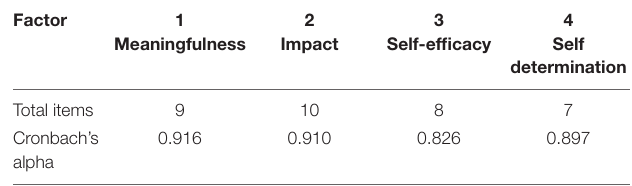
TABLE 4 | Rotated component matrix a . TABLE 5 | Reliability result.